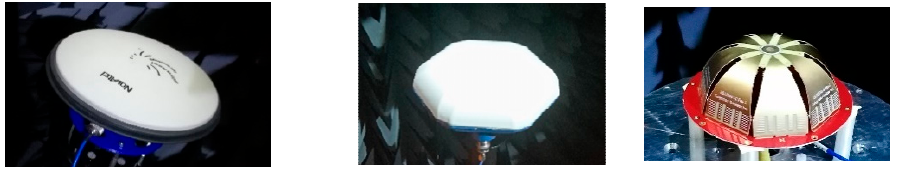
Figure 5. Novatel 703-GGG, Navxperience Nav3G+C, and Tallysman Verostar VSE6028, all in the anechoic chamber at DLR.